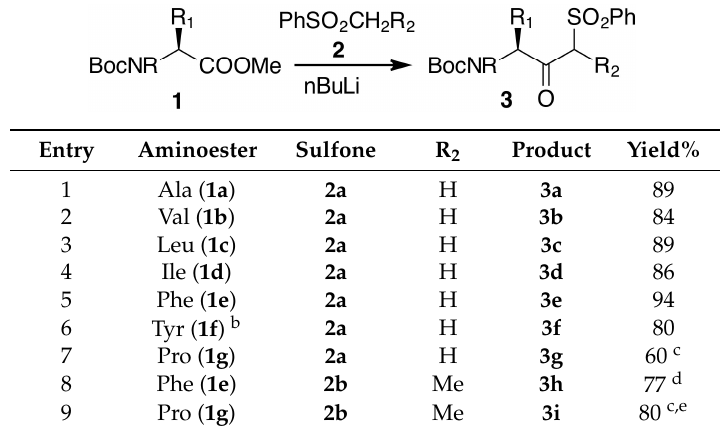
Table 2. Reactions between amino esters 1 and lithiated sulfones 2 a .